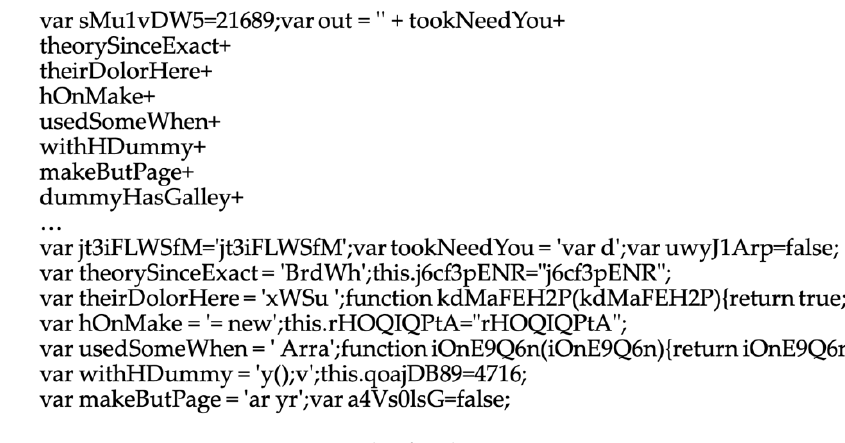
Figure 10. Example of malicious JavaScript content.